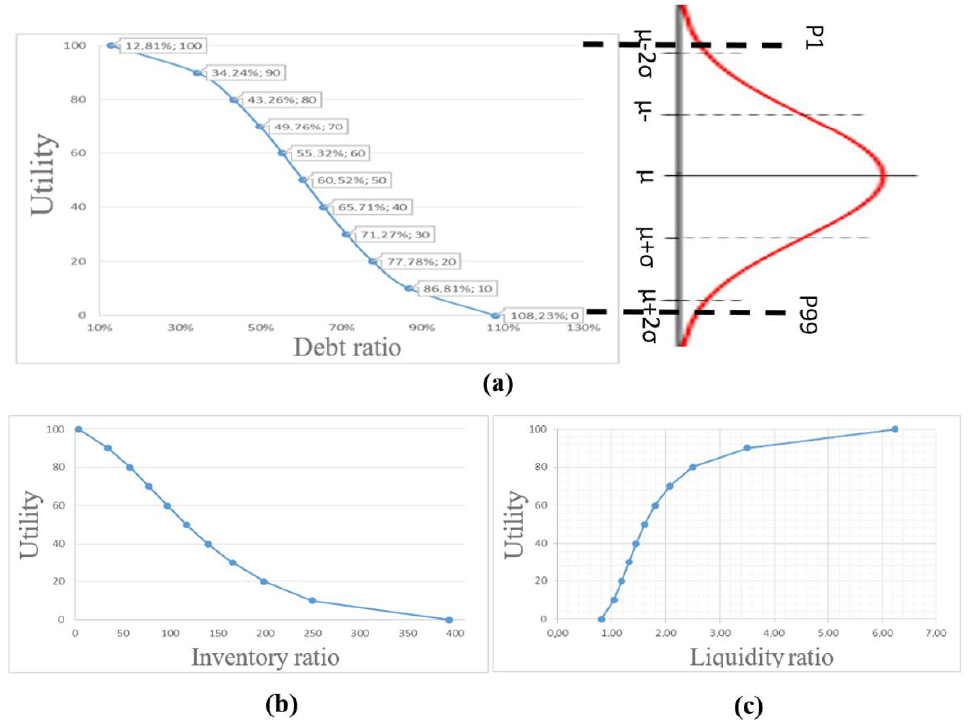
Figure 3. Criteria utility functions to build financial status indicator. ( a ) Debt ratio. ( b ) Inventory ratio. ( c ) Liquidity ratio.